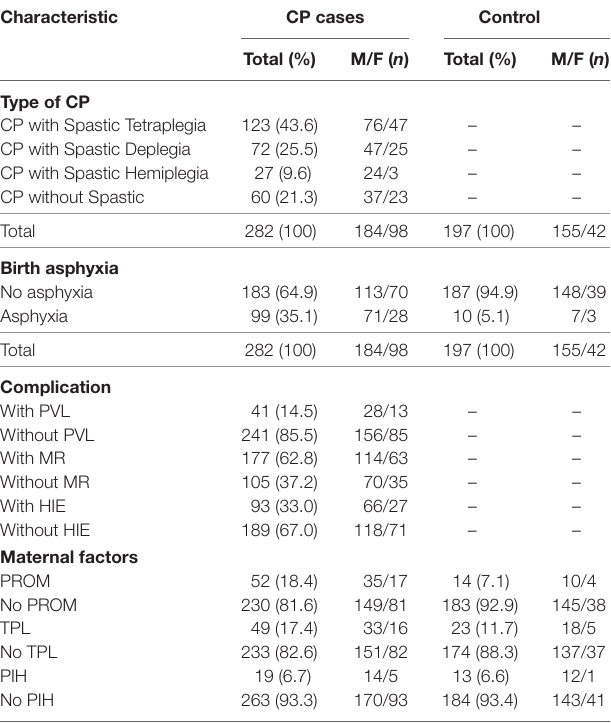
TaBle 1 | Sample description for gene polymorphism